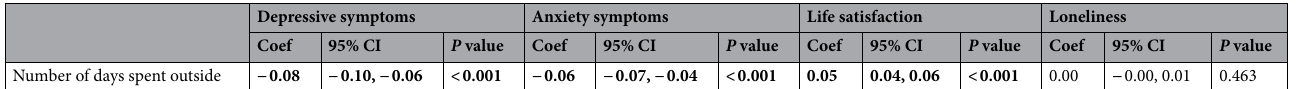
Table 2. Fixed-effects models estimating the associations between days spent outside and mental health and mental wellbeing (N = 35,301; n = 155,366). The models controlled for all time-invariant variables and time- varying variables including number of days respondents have had face to face contact with others for ≥ 15 min in the past 7 days, number of days respondents have had phone/video call with others for ≥ 15 min in the past 7 days, perceived social support, compliance with the government isolation guidance, and self-isolation status. Significant values are in